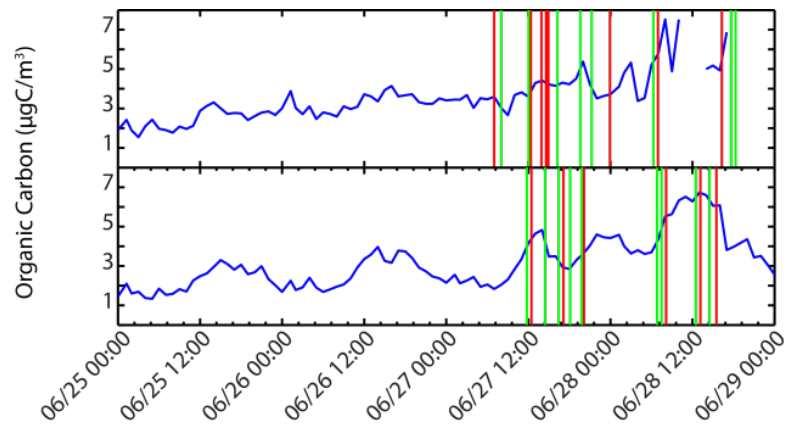
Figure 3. Organic carbon mass concentrations for particles smaller than 2.5µm diameter as determined with the Sunset OCEC analyzer. Times for samples selected for STXM/NEXAFS analysis (red vertical lines) and for CCSEM/EDX analysis (green vertical lines) are indicated in the figure.